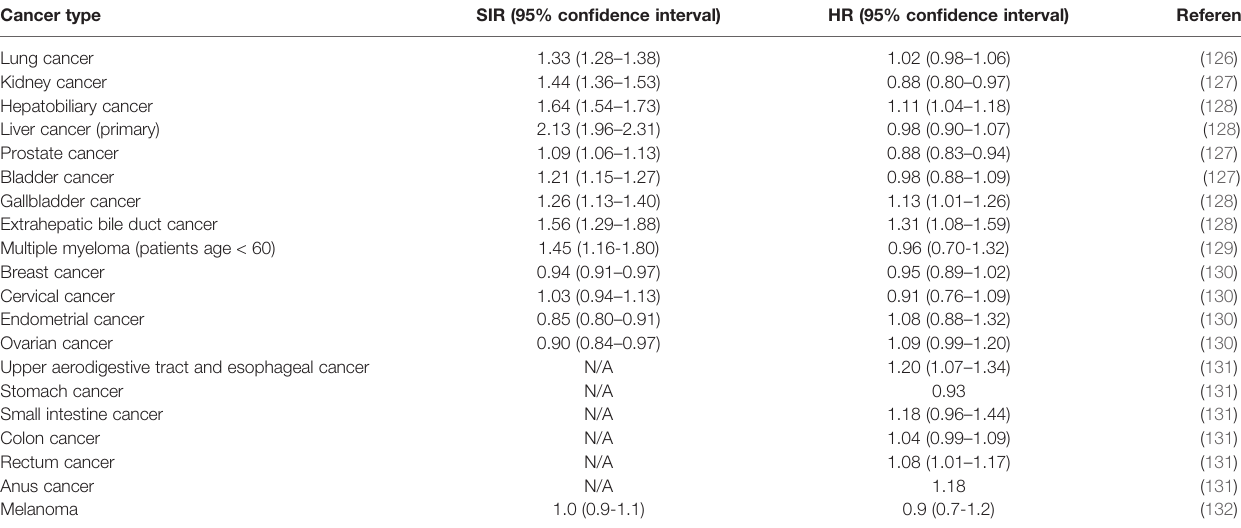
TABLE 2 | Standardized incidence ratios (SIR) and cancer-speci fi c hazard ratios (HR) (averaged over a wide-range of autoimmune diseases) for different types of cancer.